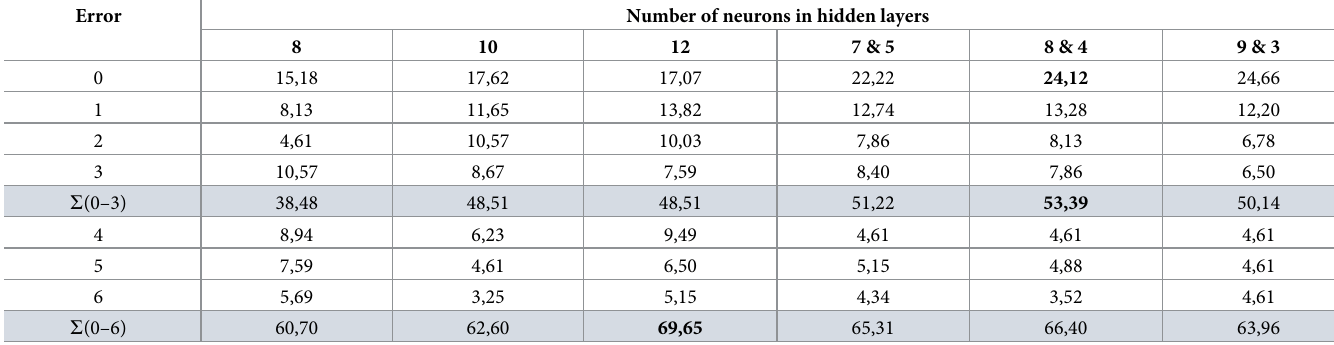
Table 2. Results of predicting horses’ positions in competitions. Error Number of neurons in hidden